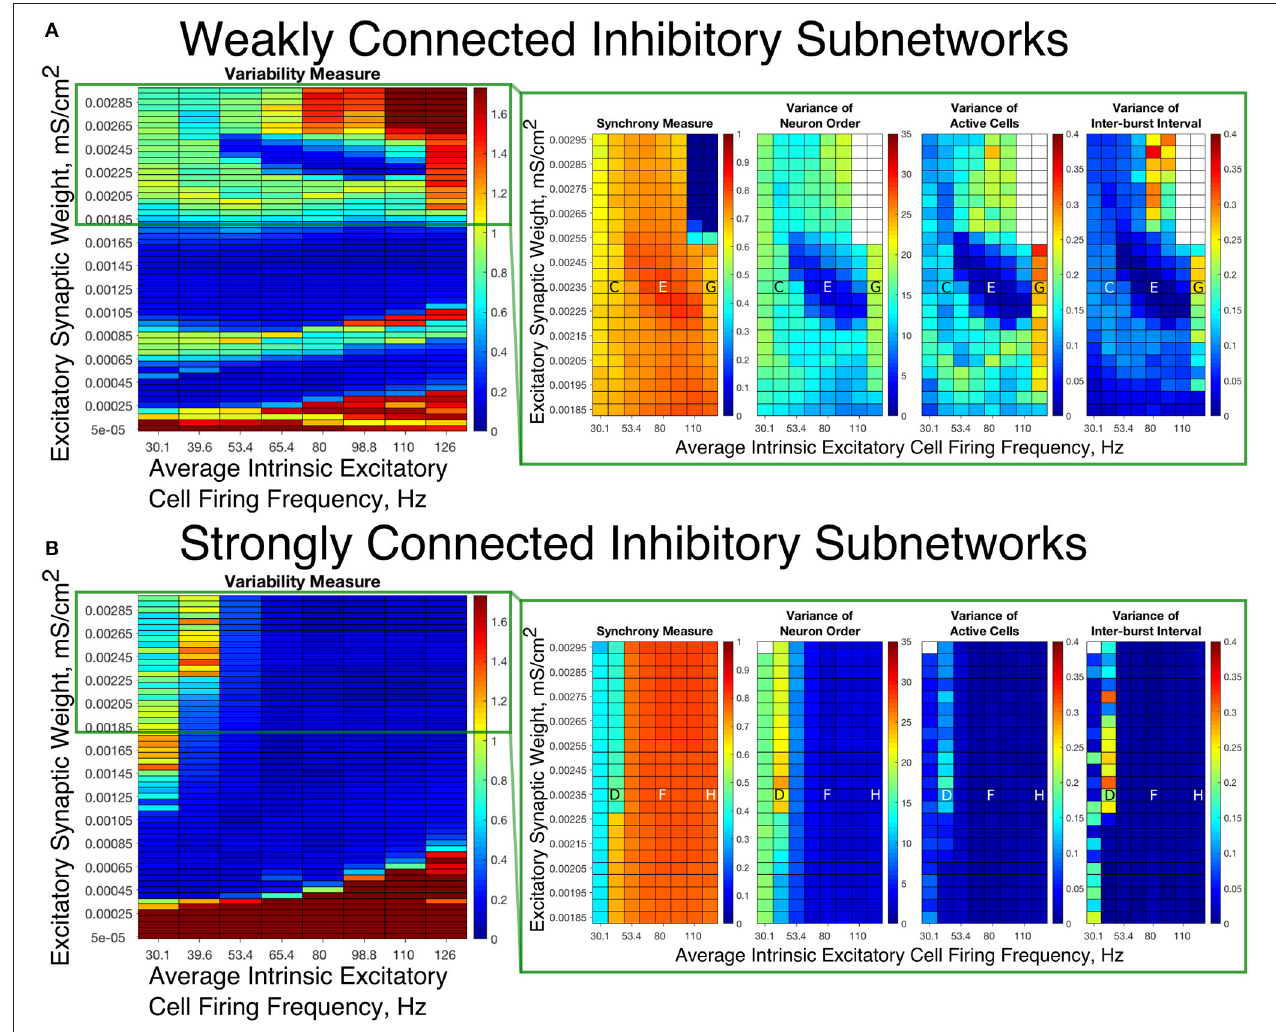
FIGURE 5 | E-I networks with weakly connected inhibitory subnetworks exhibit excitatory bursting with high variability for high values of the E-I synaptic weight despite exhibiting synchrony in this parameter regime; in contrast, E-I networks with strongly connected inhibitory subnetworks exhibit mostly low variability firing in this parameter regime. (A,B) Variability Measure (left panel) calculated over the entire parameter range studied, with the parameter regime of particular interest outlined in green. For this parameter regime of interest, we show the Synchrony Measure along with the three measures that are used to calculate the Variability Measure (Variance of Neuron Order, Variance of Active Cells, and Variance of Inter-burst Intervals) in the green box making up the right panel. White entries in the heatmaps indicate that the excitatory network did not achieve sufficient synchrony for the given measure to be accurately calculated for that network. Overlaid letters indicate parameter values of example raster plots in Figure 3 . Results for E-I networks with weakly connected inhibitory subnetworks are shown in (A) , while results for E-I networks with strongly connected inhibitory subnetworks are shown in (B) . In the parameter regime of interest, networks with strongly connected inhibitory subnetworks almost exclusively exhibit bursting patterns with low variability, while networks with weakly connected inhibitory subnetworks show a much higher Variability Measure due to the higher values of the Variance of Neuron Order, Variance of Active Cells, and Variance of Inter-burst Intervals for most networks in this parameter